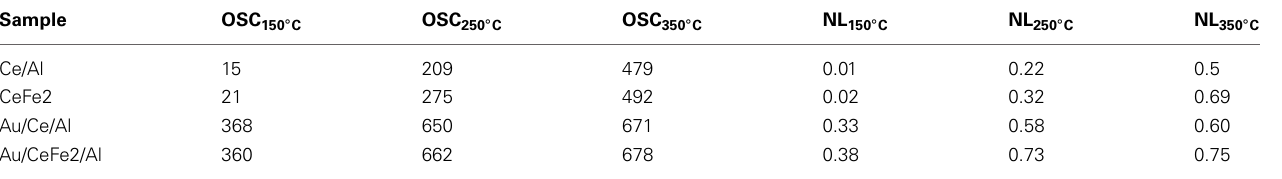
Au/CeFe2/Al 360